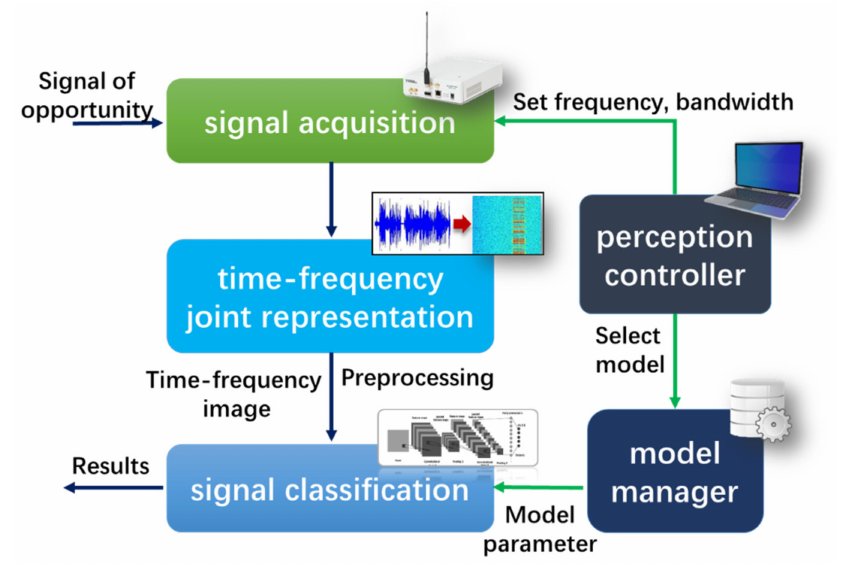
Figure 8. The structure of the signal perception